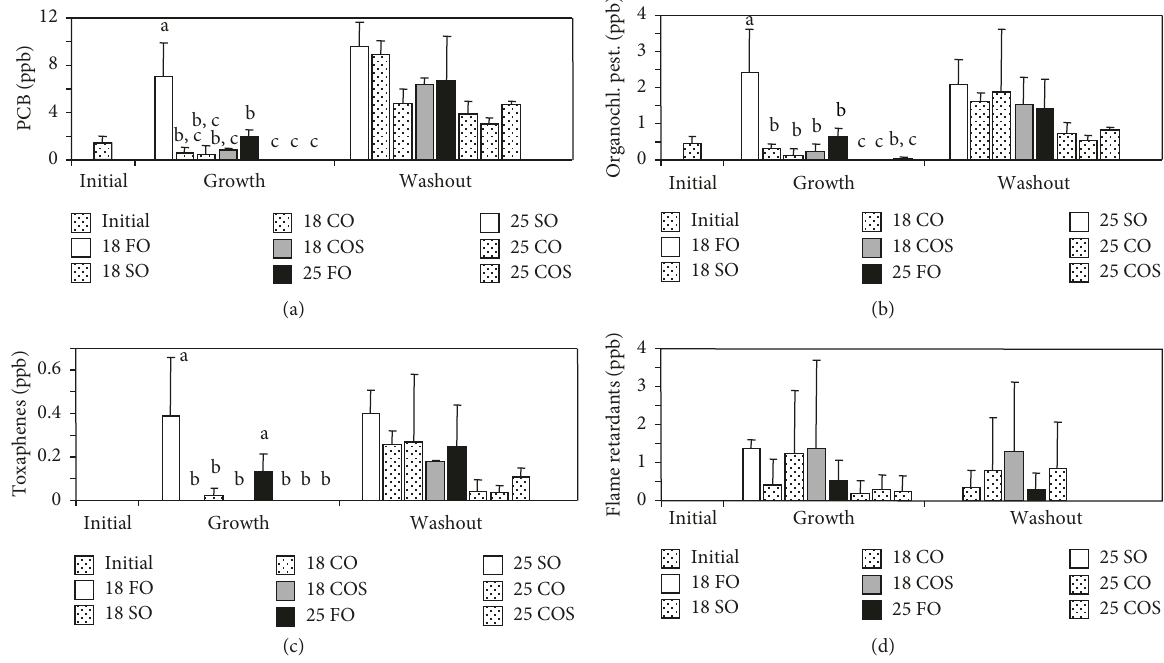
Figure 2: Concentrations of (a) PCBs (ppb), (b) organochlorine pesticides (ppb), (c) toxaphenes (ppb), and (d) flame retardants (ppb) in initial fish, at the end of growth period, and at the end of washout period.18 FO, 18 DP/DE diet with 100% fish oil; 18 SO, 18 DP/DE diet with 75% soybean oil; 18 CO, 18 DP/DE diet with 75% canola oil; 18 COS, 18 DP/DE diet with 75% blend of canola oil and Schizochytrium sp.; 25 FO, 25 DP/DE diet with 100% fish oil; 25 SO, 25 DP/DE diet with 75% soybean oil; 25 CO, 25 DP/DE diet with 75% canola oil; 25 COS, 25 DP/DE diet with 75% blend of canola oil and Schizochytrium sp.; DM, dry matter; DP/DE, digestible protein/digestible energy (lipids). Data represent the mean of three replicates for initial data and growth trial; duplicates for washout trial. The error bars represent standard errors. Within the growth period, different superscripts indicate significant differences ( p < 0 .